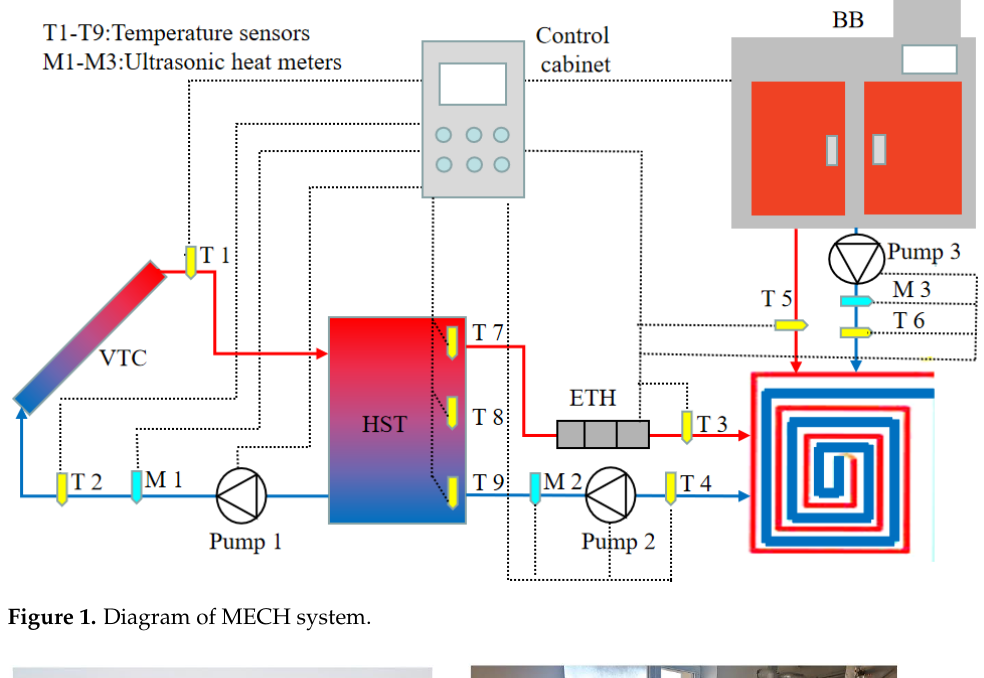
Energies 2022 , 15 , x FOR PEER REVIEW